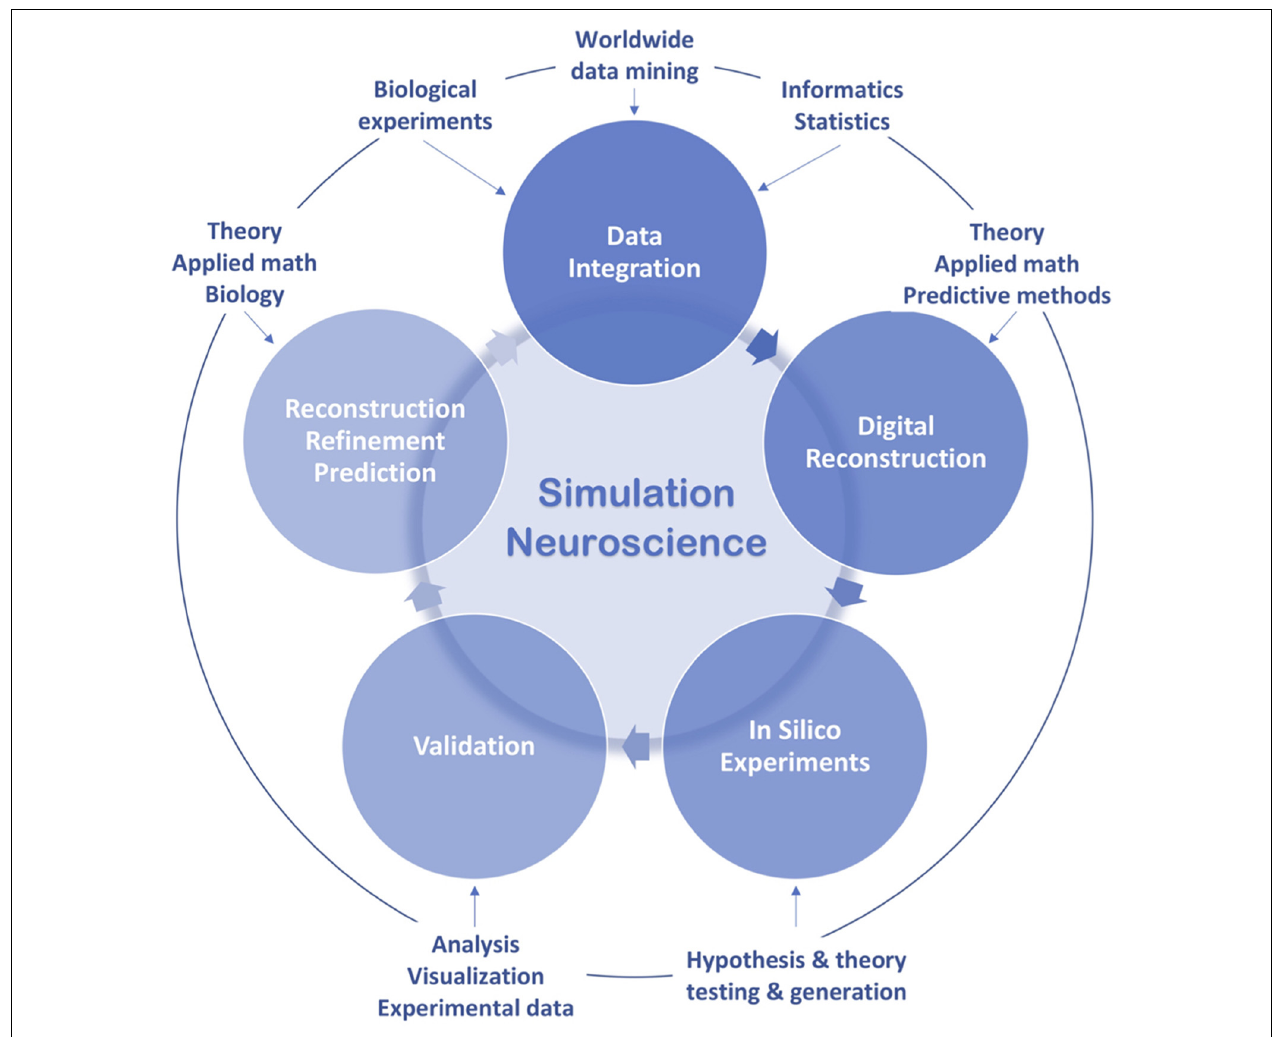
FIGURE 3 | Simulation neuroscience